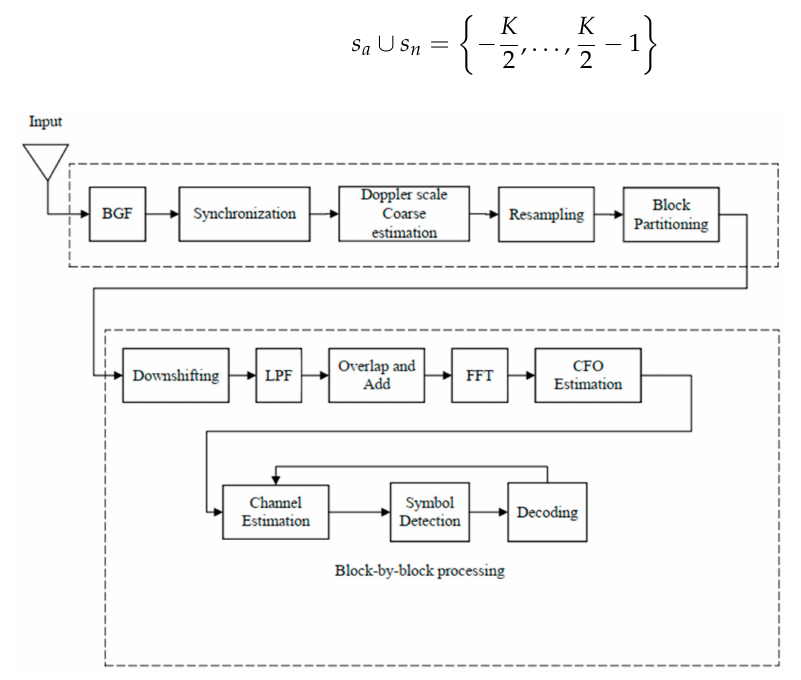
Figure 8. OFDM receiver for UWACs